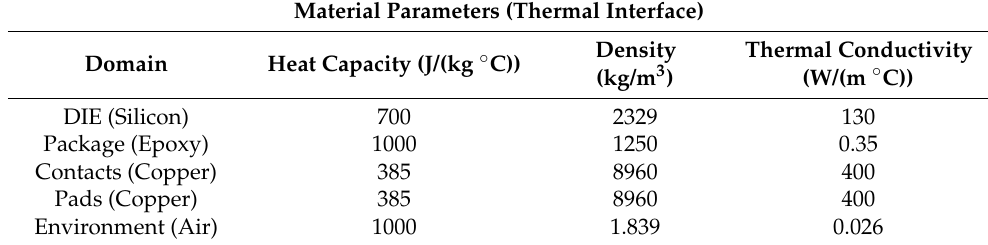
Table 3. General Material Settings (Thermal Interface).